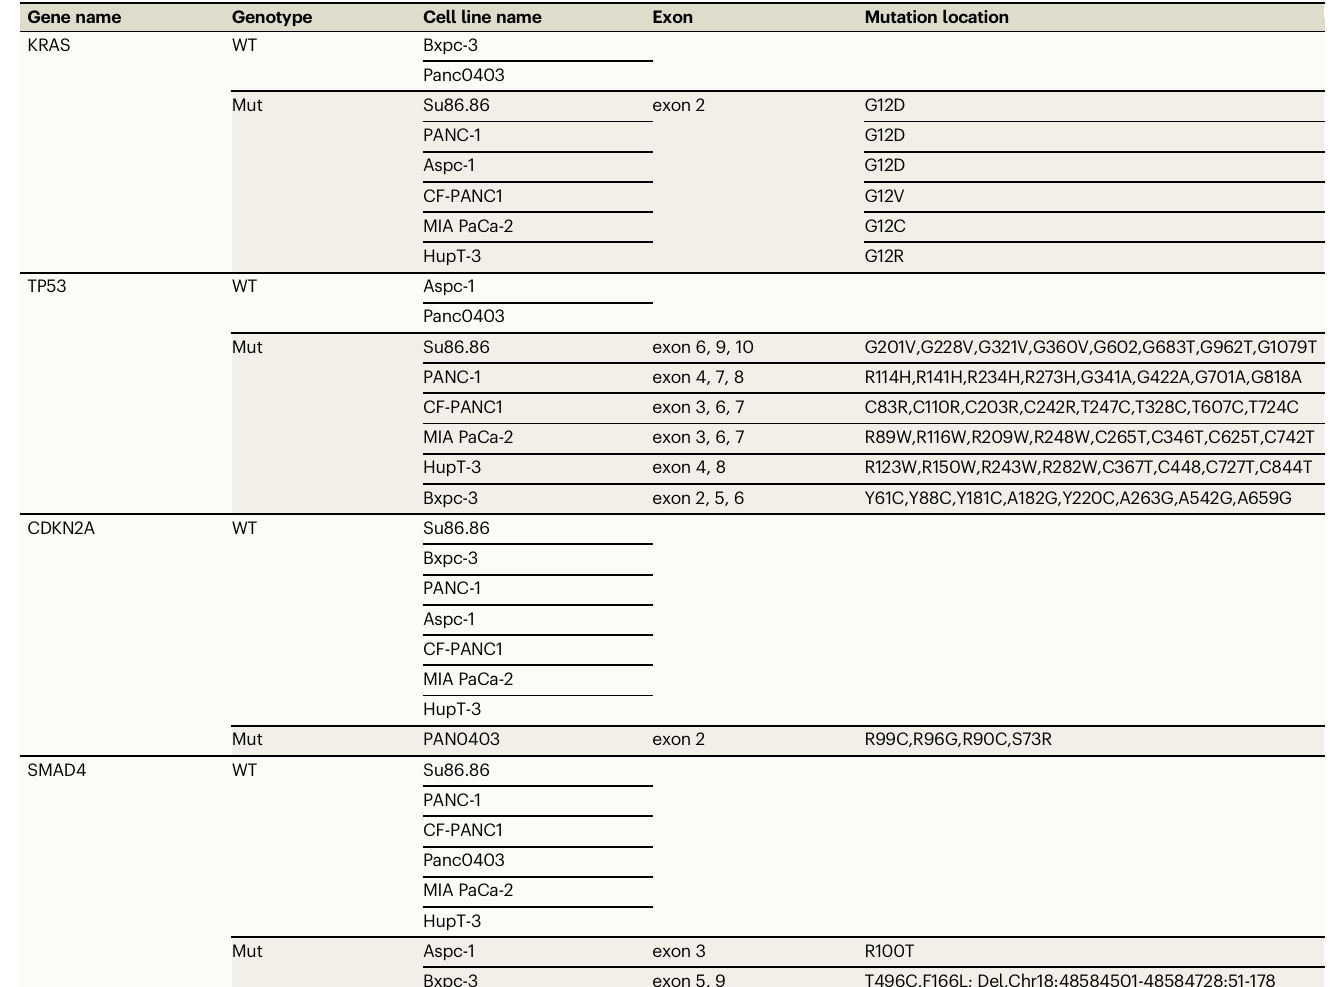
Table 1 | Genotypic pro fi les of four drivers in different PDAC cell